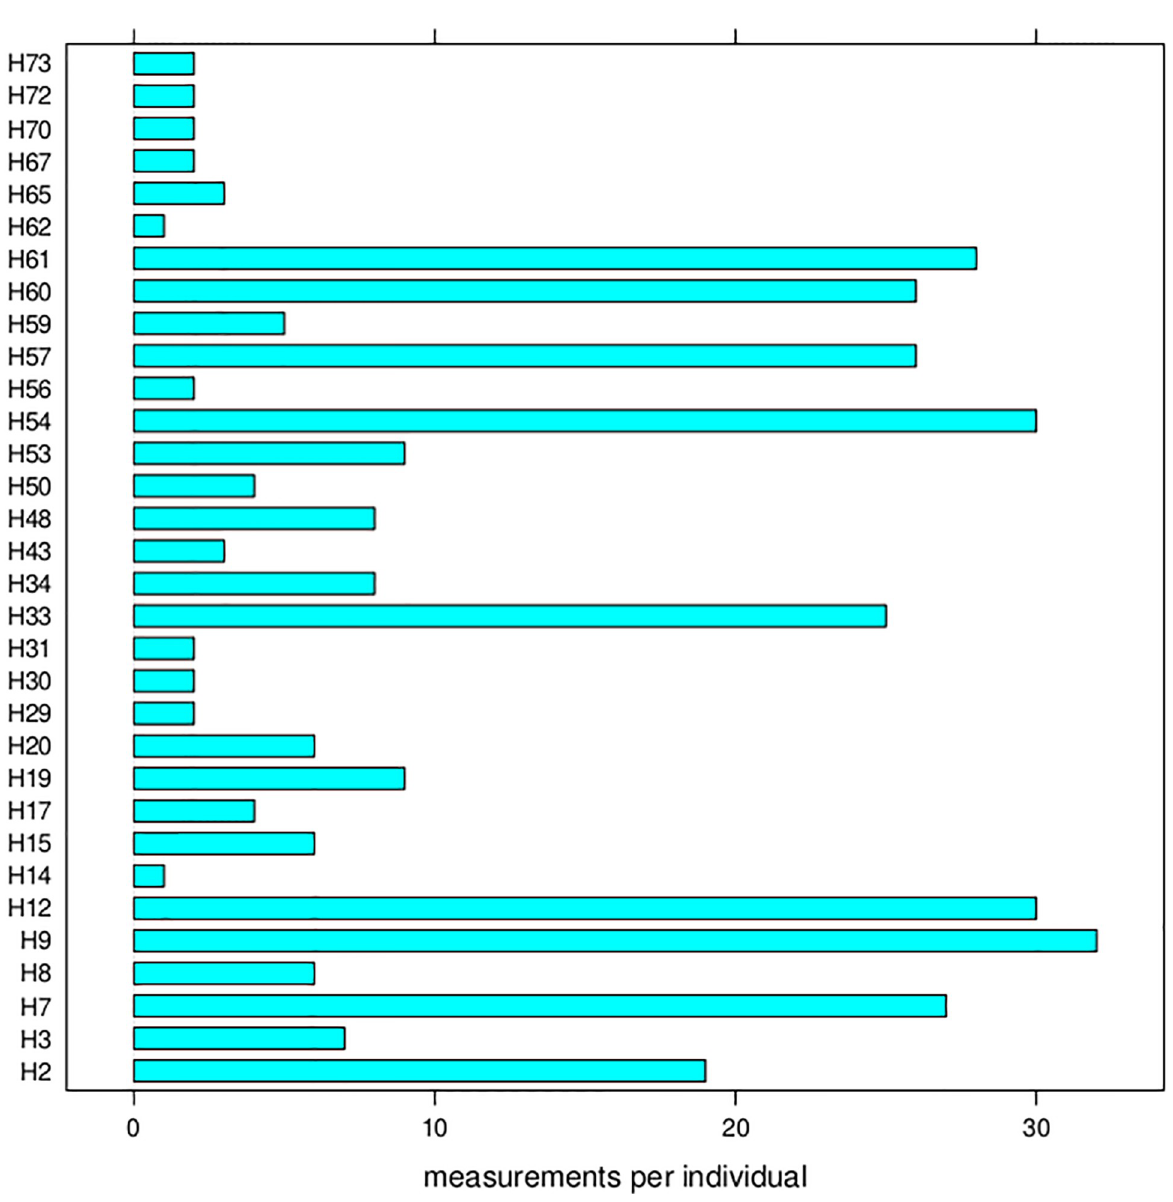
Fig 1. Number of measurements (focus counts over 500 cells) per individual, where the labels on the vertical axis are the anonymized codes of the individuals (donors).